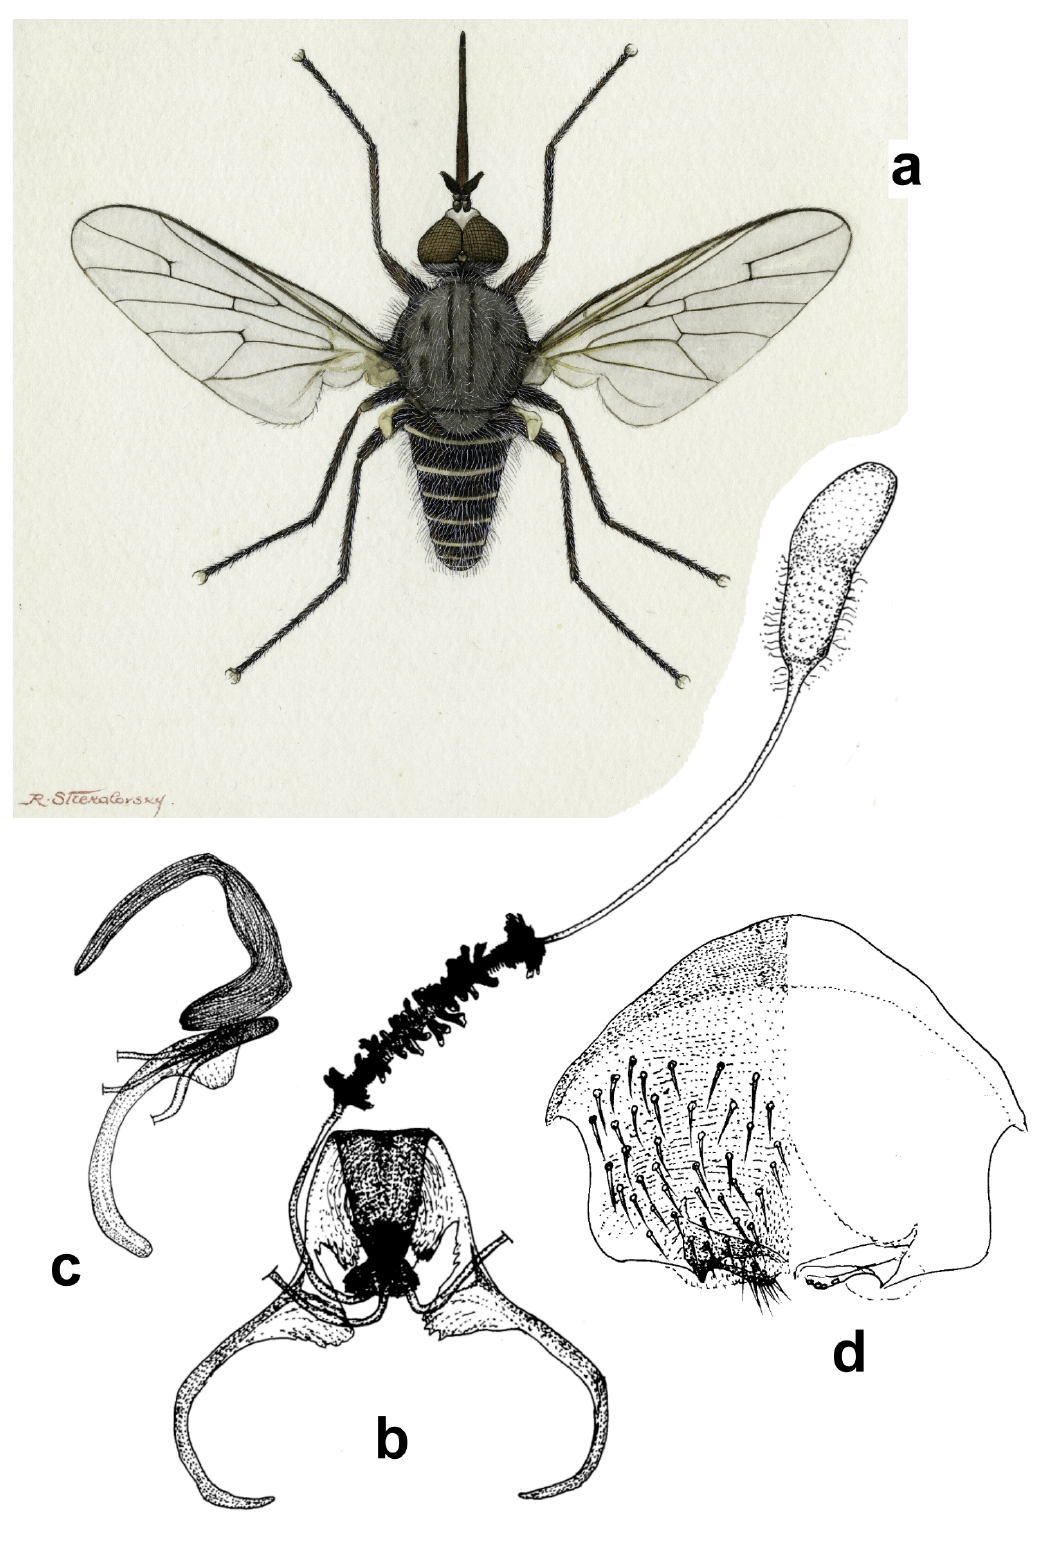
Fig. 49. Protypusia inornata (Engel, 1932) gen. et comb. nov. a . Habitus male, Smithsonian Institution Archives Image SIA2012-7885-wing venation aberrant. b–d . Protypusia cf. inornata , Senegal specimen b . Female genitalia ventral. c . Female genitalia lateral. d . Female sternite 8